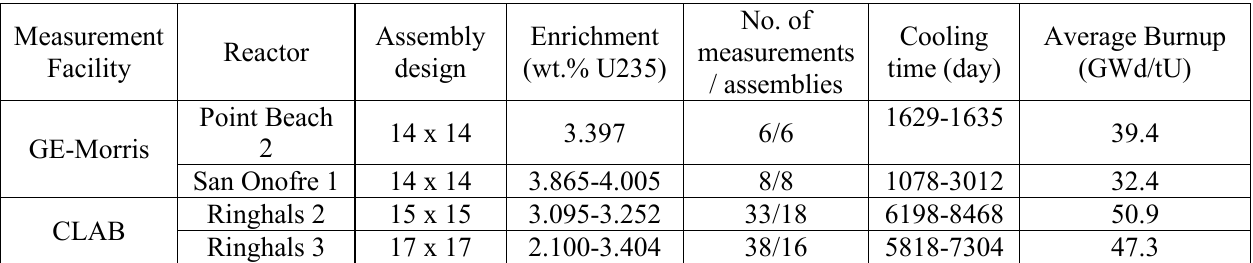
Table III . Summary of full-length fuel assembly measurements